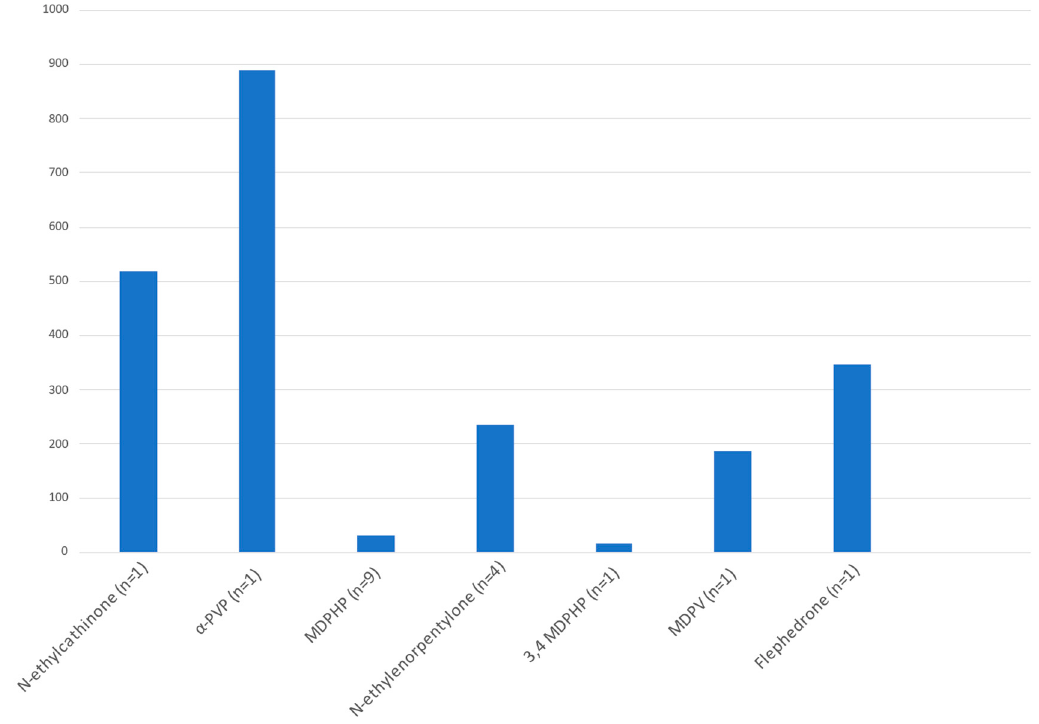
Figure 6. Di ff erent blood concentrations of SCs in intoxication cases. Figure 6. Different blood concentrations of SCs in intoxication